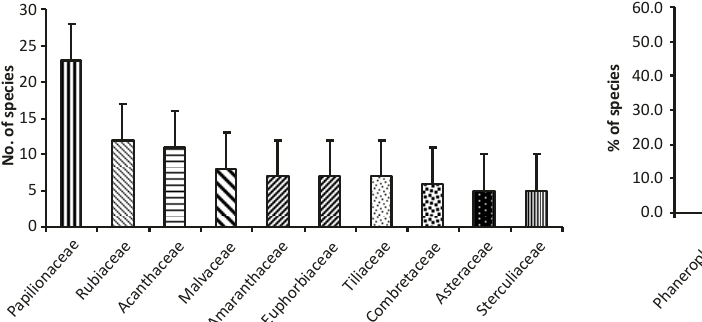
Figure 2. Predominant angiosperm families making the vegetation stands in the Kawal Wildlife